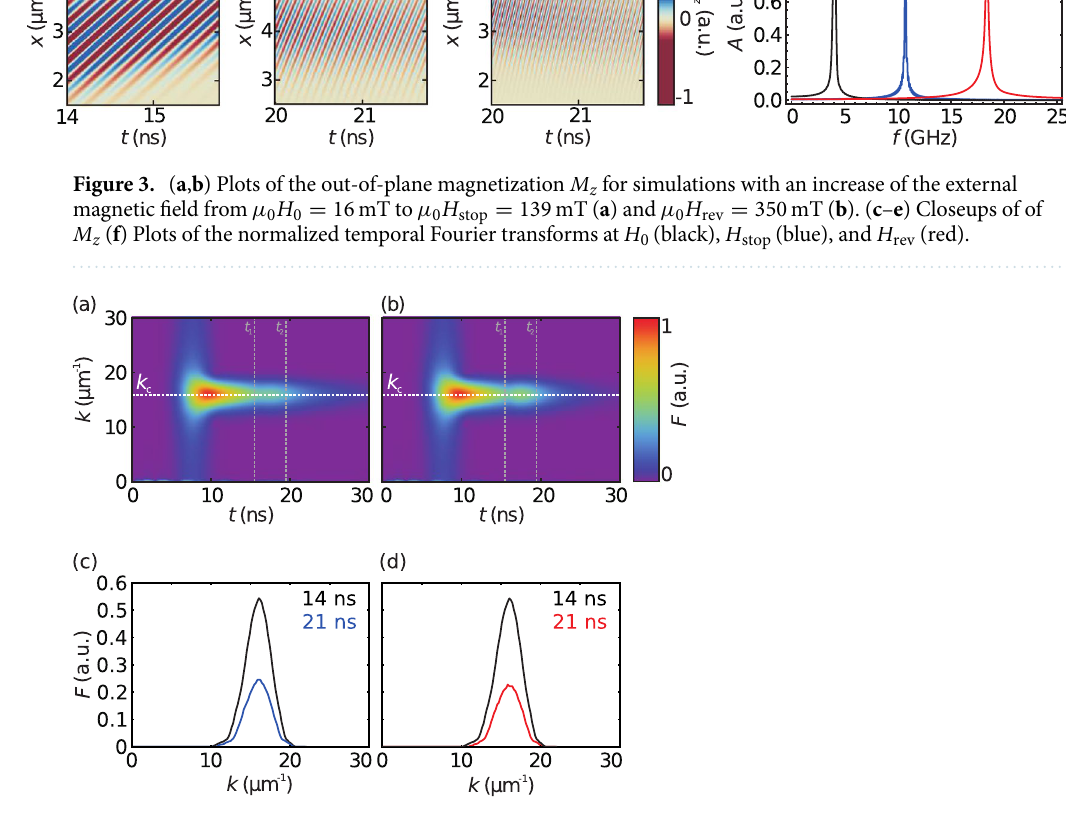
Figure 4. Time dependent spatial Fourier transform of M z for simulations of a field increase to H stop ( a ) and H rev ( b ). The white dashed line marks the central wave number k c determined from the Fourier transforms. Profiles of the spectra at t = 14 ns and t = 21 ns are provided in panels ( c ) and ( d ) for simulations of a field increase to H stop and H rev ,